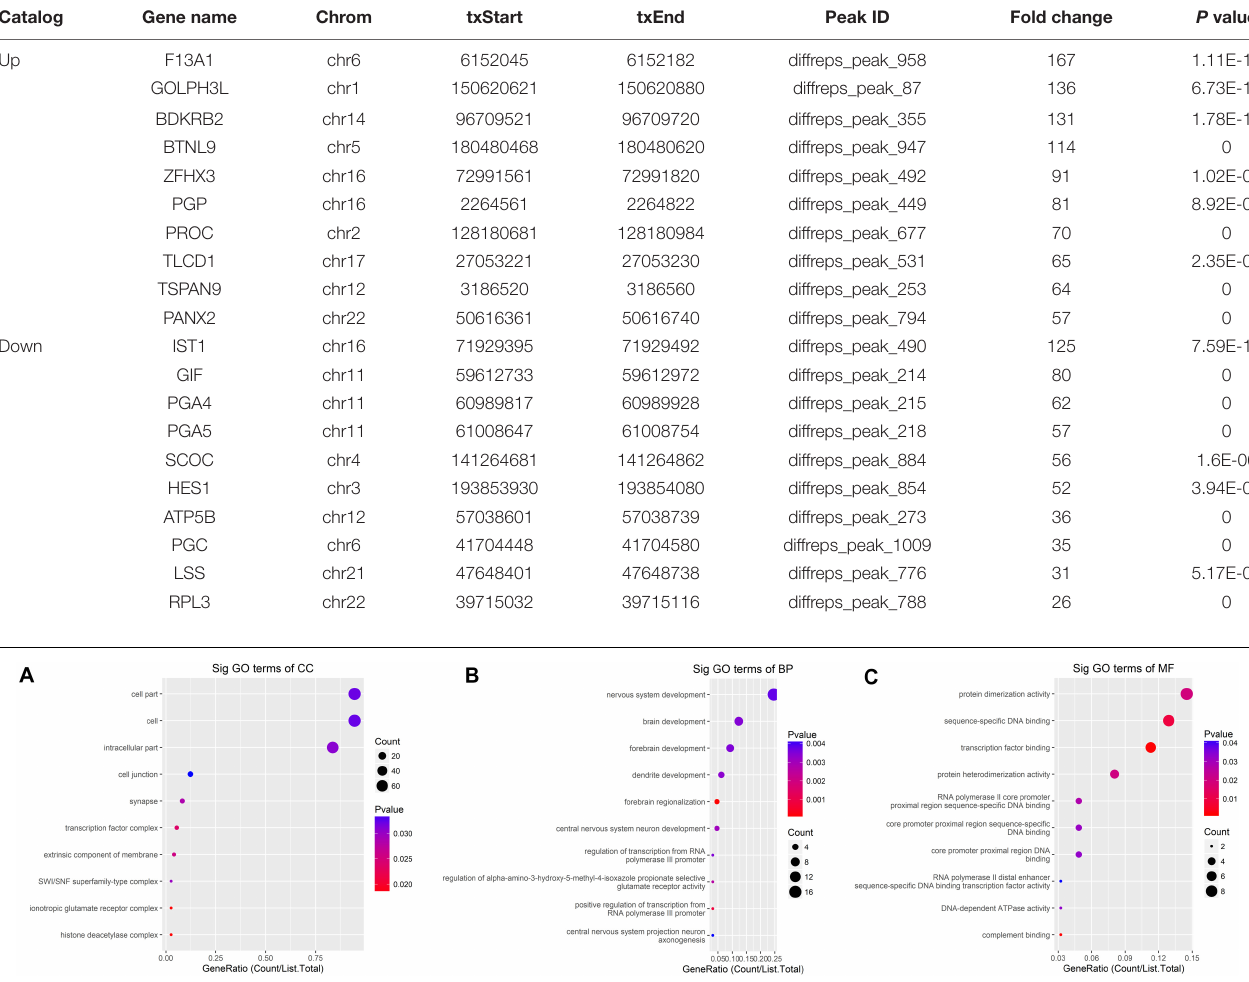
TABLE 2 | Top 10 up- and down-regulated differential methylated genes in GC tissues.